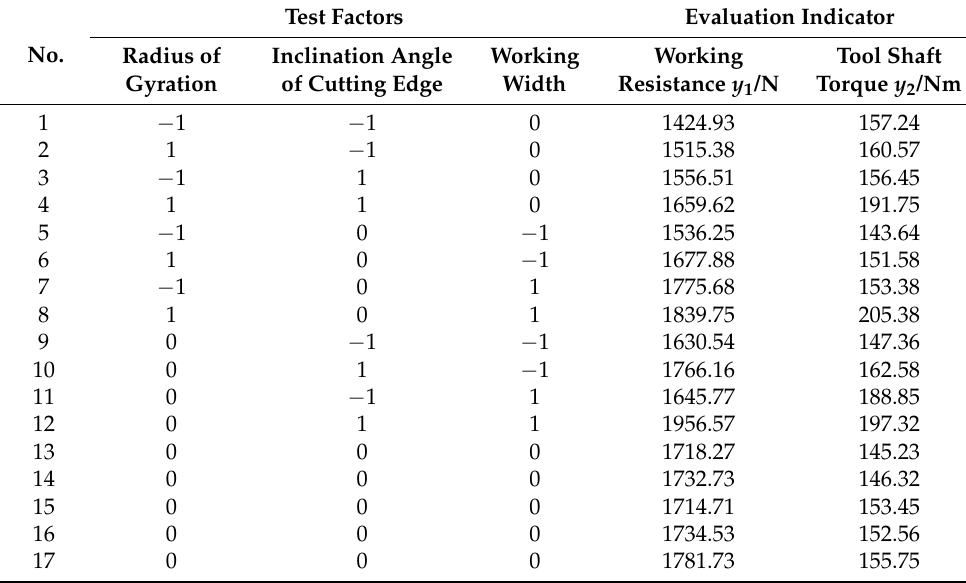
Table 6. Results of multi-factor